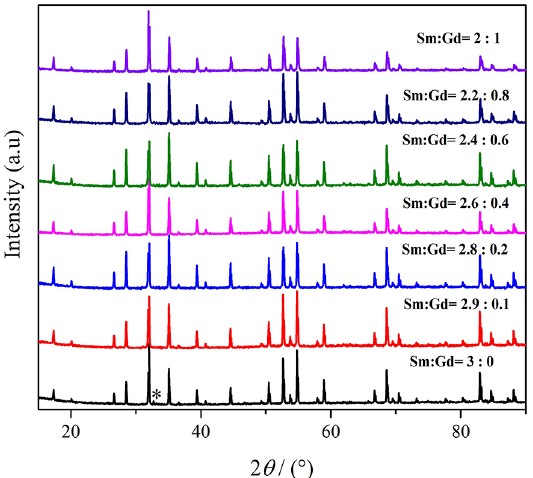
Figure 1. Diffractograms of garnet-type system Sm (REE= Gd) with x = 0.0, 0.1, 0.2, 0.4, 0.6, 0.8 and 1.0. (* SmFeO